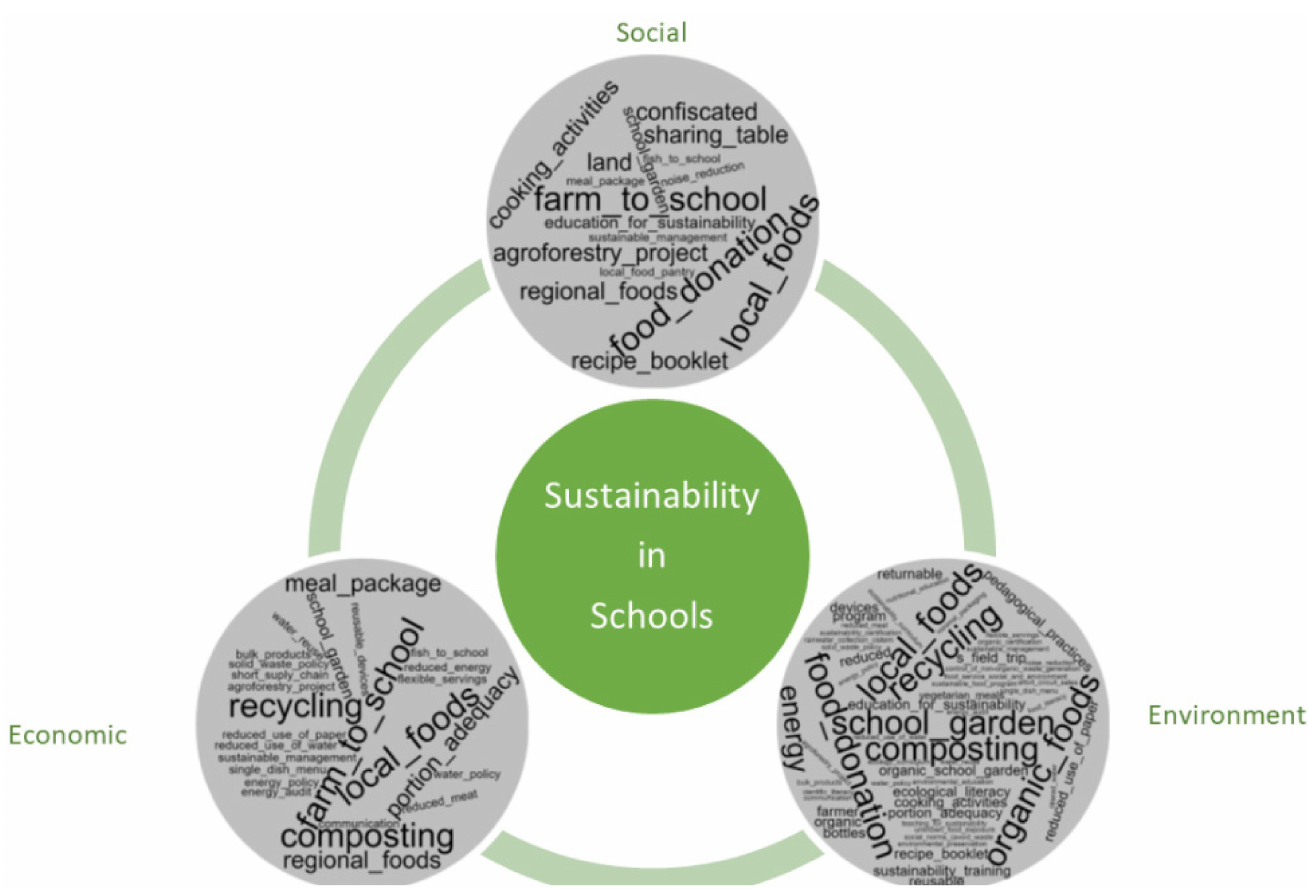
Figure 2. Identified sustainable practices in schools according to the environmental, economic, and social